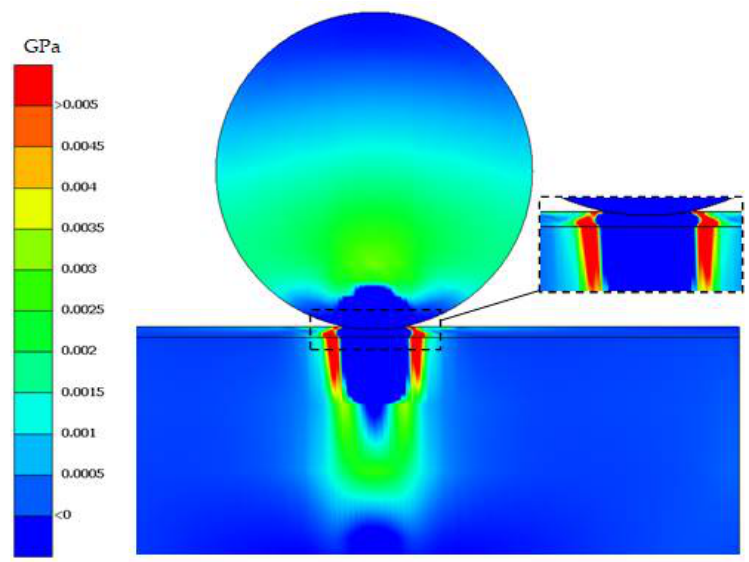
Figure 15. The first principal stress conturs in the contact region.